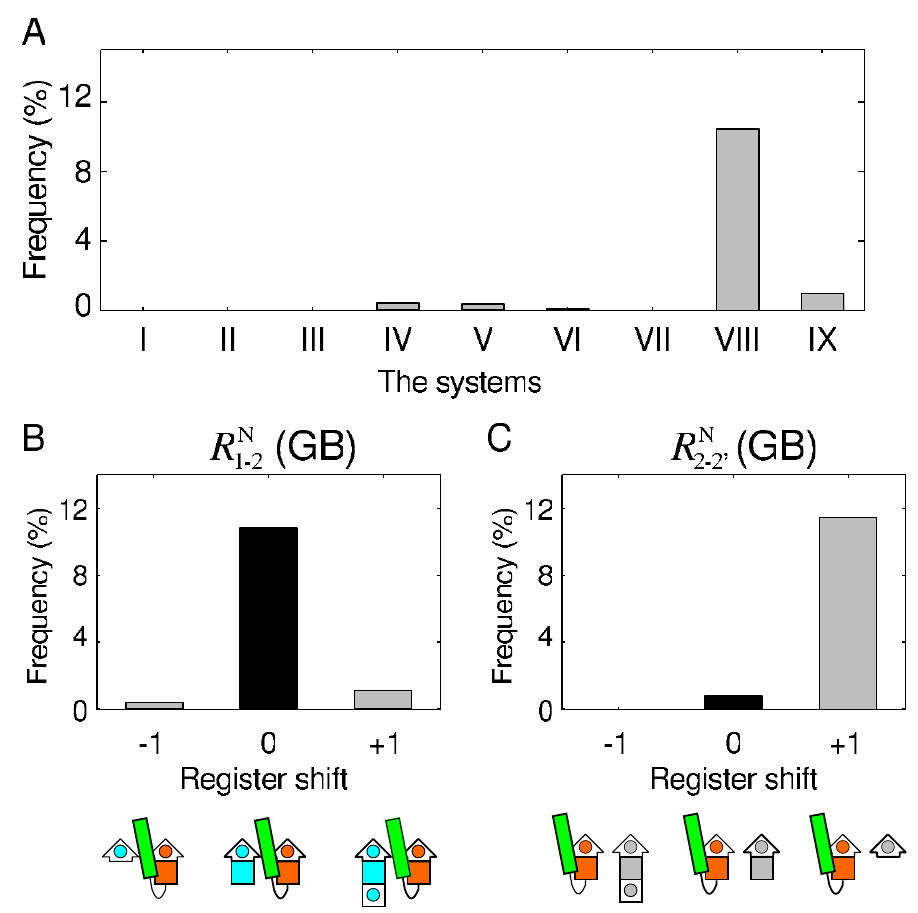
ð GB Þ and (C) that of R N ð GB Þ . The values 1 (cid:0) 2 2 (cid:0) 2 0